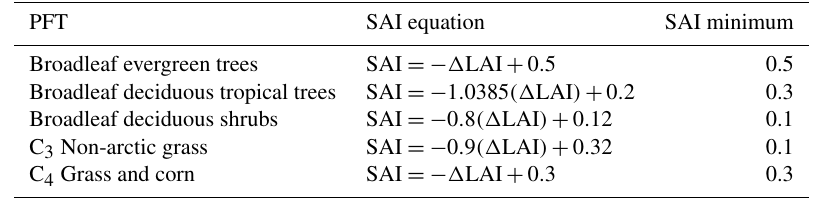
Table 5. Equations for calculating SAI for each PFT in CLM-AF. PFT SAI equation SAI minimum Broadleaf evergreen trees SAI = − (cid:49) LAI + 0 .